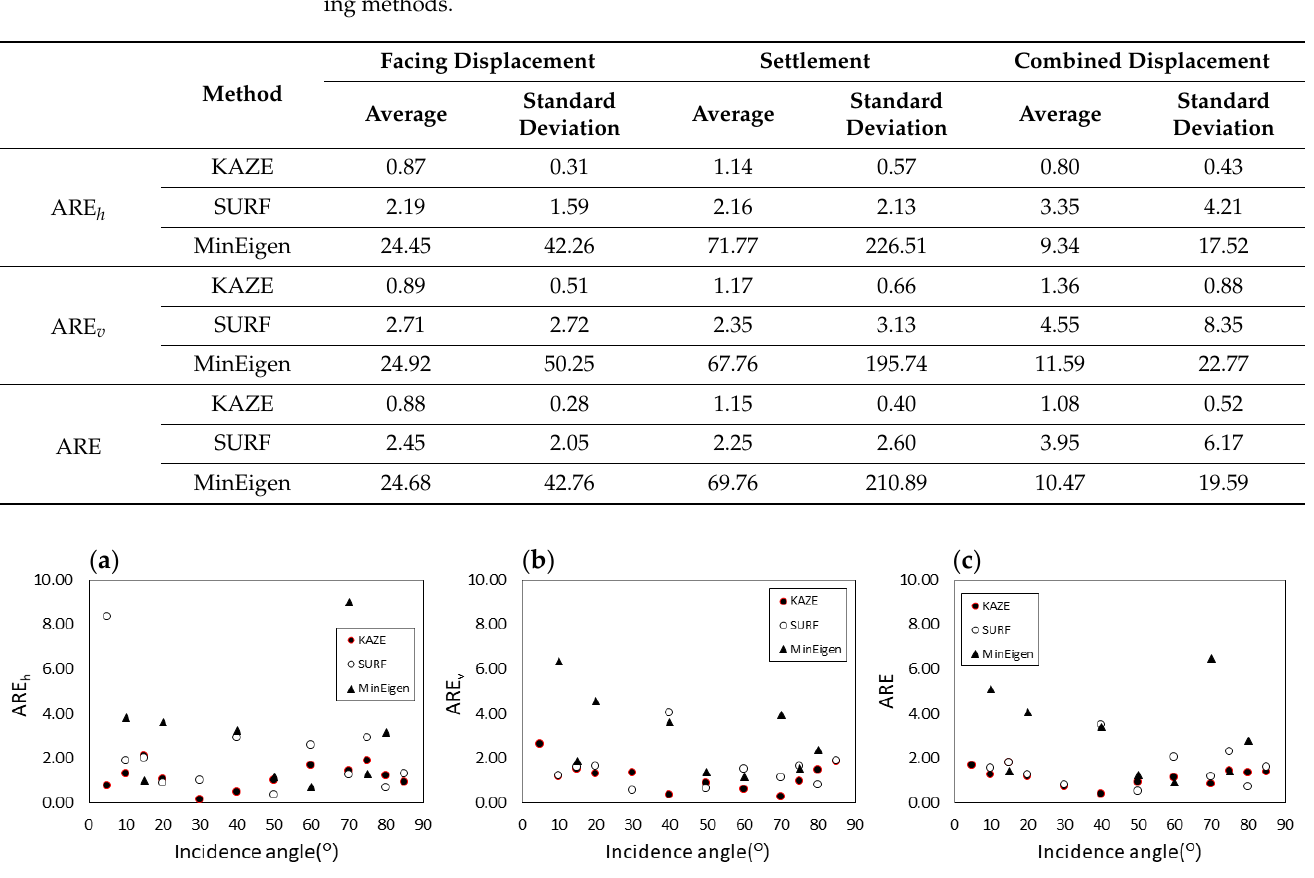
Figure 9. Distribution of ARE h , ARE v , and ARE with different feature matching methods at settlement. ( a ) ARE h ; ( b ) ARE v ; ( c ) ARE.